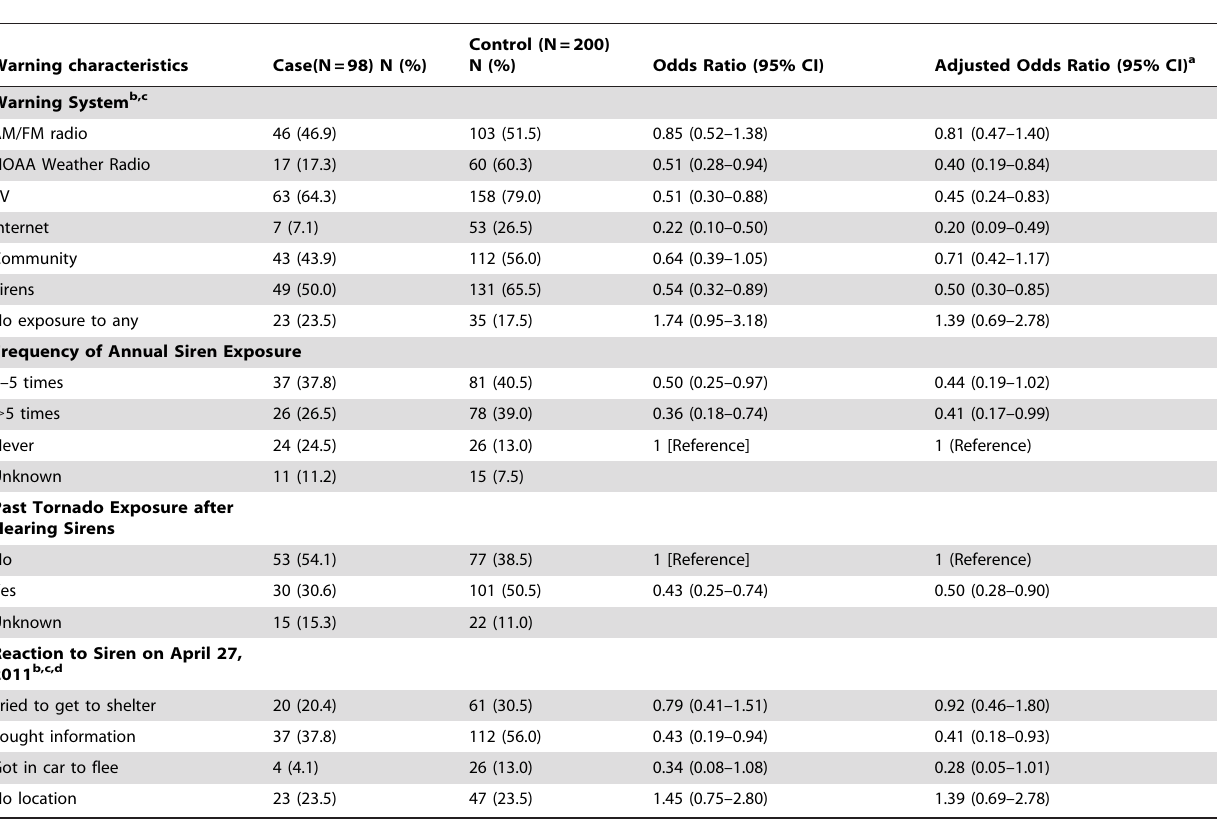
Table 4. Odds of injury associated with exposure and reaction to warning systems among surveyed cases (N=98) and controls (N=